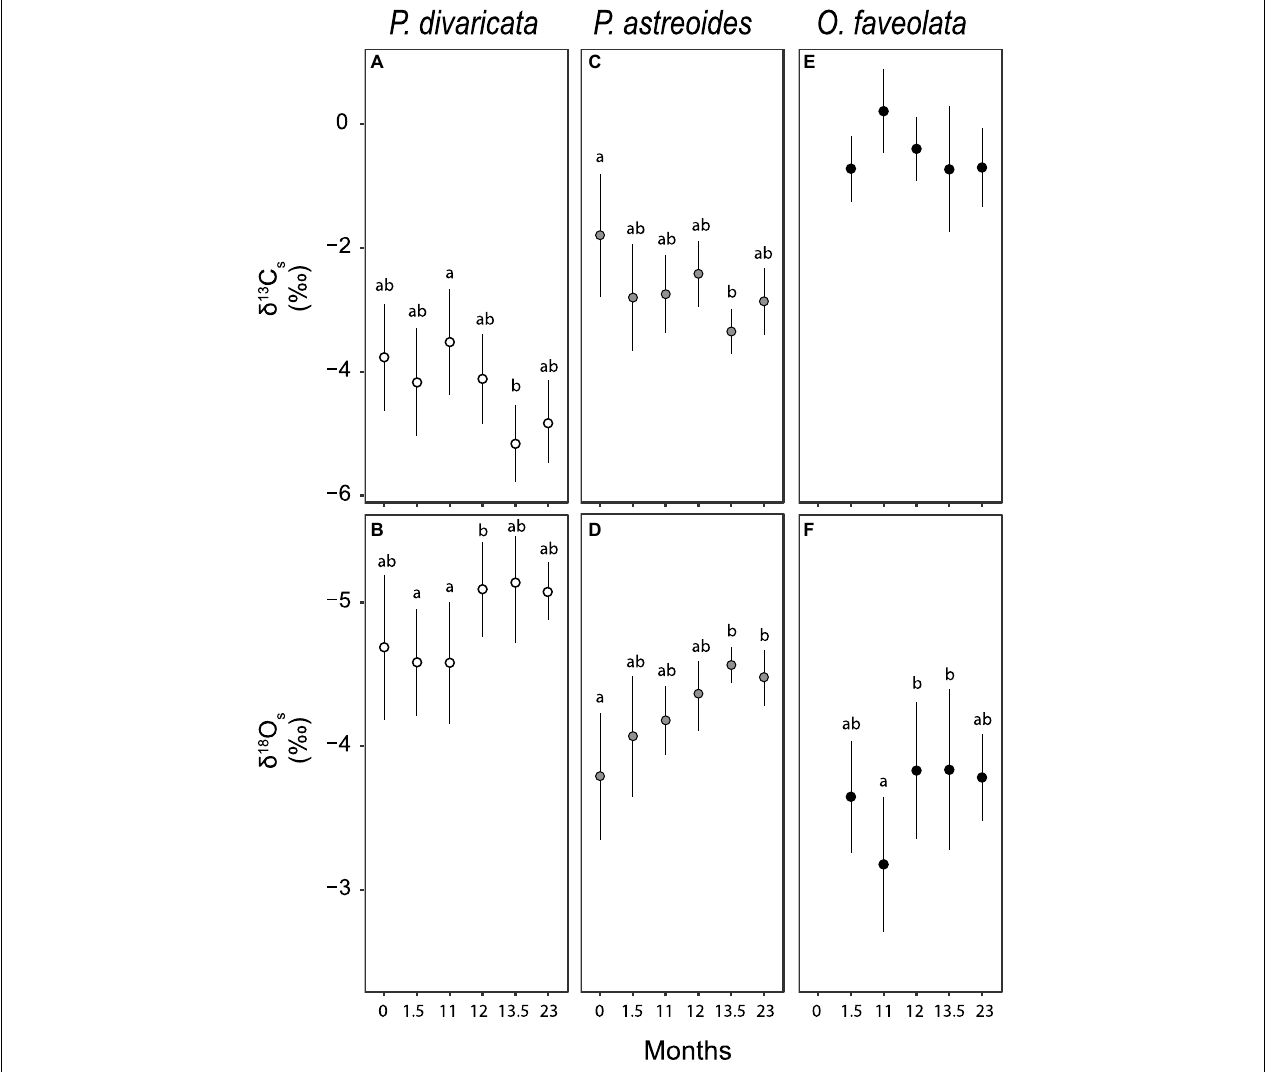
FIGURE 6 | Average ( ± 1 SE) skeletal stable (A,C,E) carbon ( δ 13 C s ) and (B,D,F) oxygen ( δ 18 O s ) isotopic values of Porites divaricata (white), Porites astreoides (gray) and Orbicella faveolata (black) at each time points (0 = July 2009, 1.5 = September 2009, 11 = June 2010, 12 = July 2010, 13.5 = September 2010, and 23 = June 2010). Sample sizes range from 5 to 9. Note that the y-axis values for δ 18 O s are inverted. All Kruskal-Wallis, ANOVA and Tukey post hoc results in Supplementary Table 6